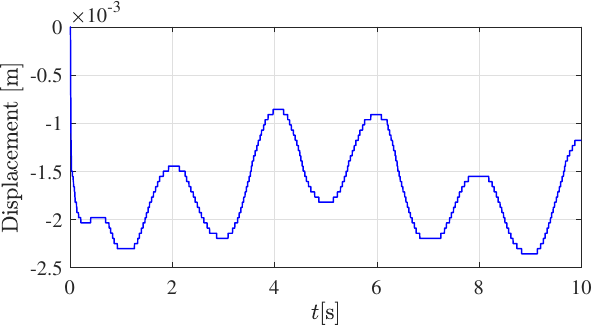
Figure 3. Measured displacement of the tissue for the Eco Flex 00-50 sample.